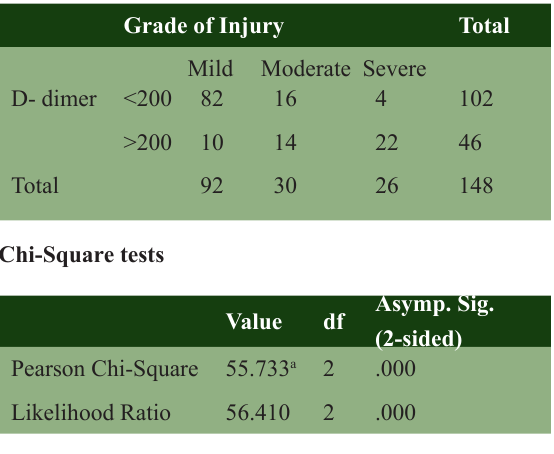
Table 5: Chi-square test showing correlation of D-dimer with mode of injury Mode of Injury